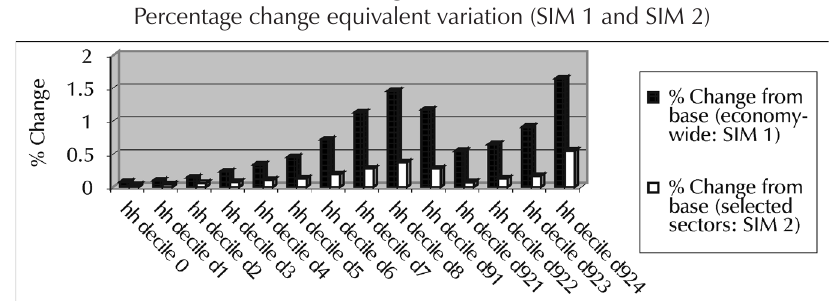
Percentage change equivalent variation (SIM 1 and SIM